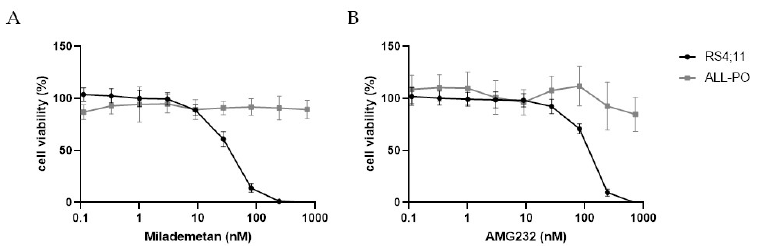
Figure 5. Efficacy of MDM2 inhibitors in KMT2A -rearranged ALL cells carrying wild-type p53 or mutated p53 : in vitro drug responses of ( A ) Milademetan (DS-3032) and ( B ) AMG232 on KMT2A– AFF1 cell lines RS4;11 ( p53 wild-type) and ALL-PO (mutated p53 ) determined by a 4-day MTT assay. Cell viability was normalized to DMSO controls. Data points are represented as the mean ± SD of n = 7 technical